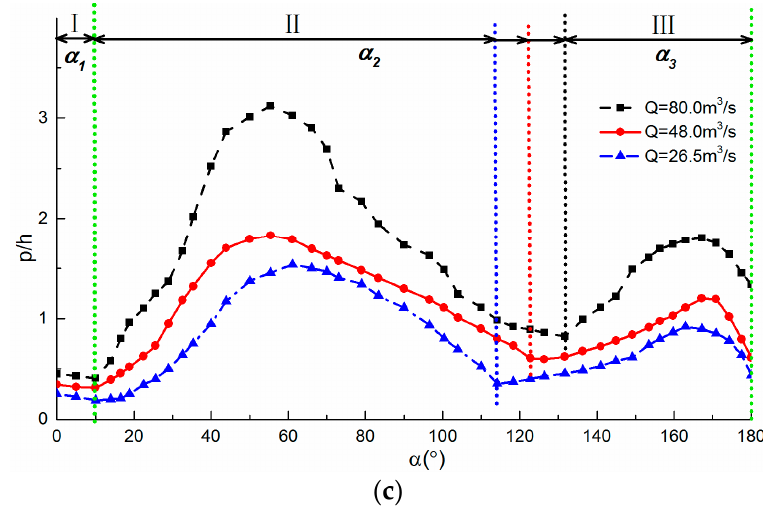
Figure 8. Pressure distribution for R = 0.25 m in different θ : ( a ) 120 ◦ ; ( b ) 150 ◦ ; and ( c ) 180 ◦ .